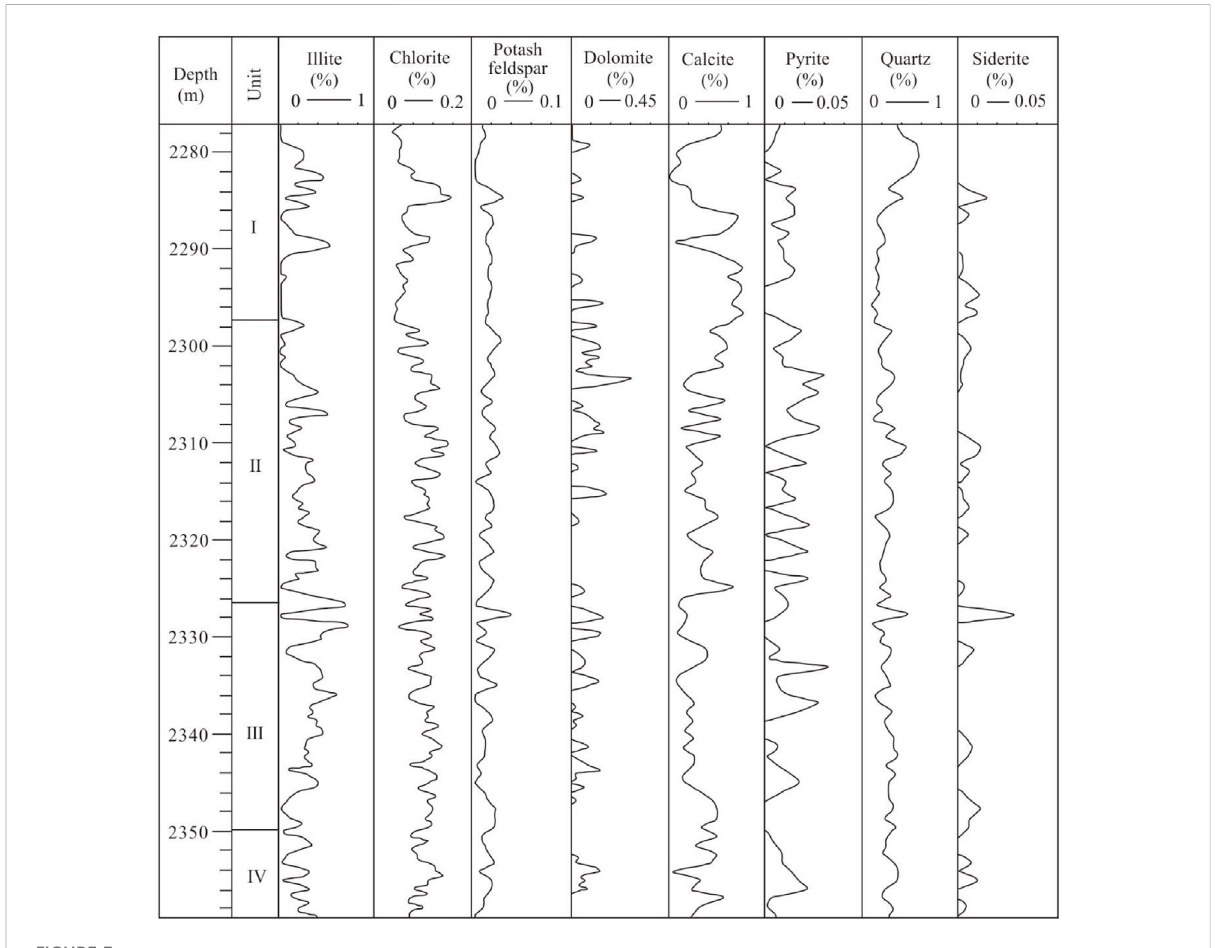
FIGURE 3 Mineral content in the Da ’ anzhai member of well